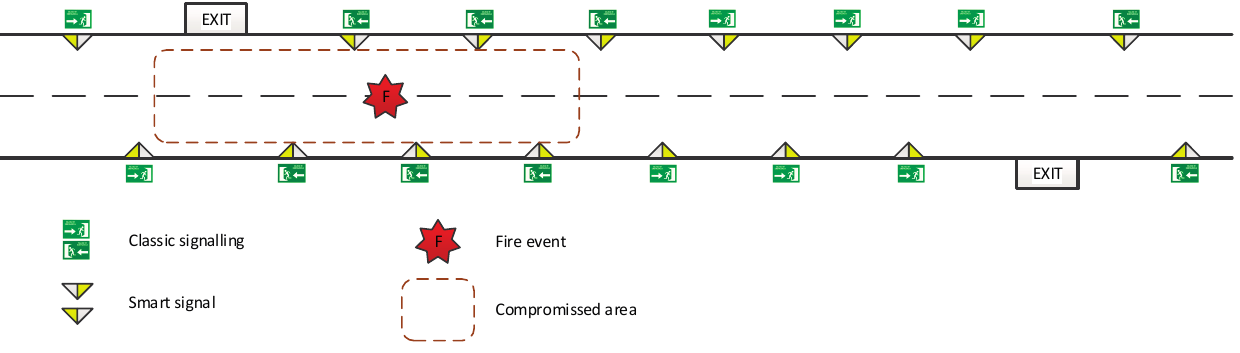
Figure 3. Smart Signal concept applied to emergency signaling in tunnels. The Smart Signals provide indications adapted to the emergency